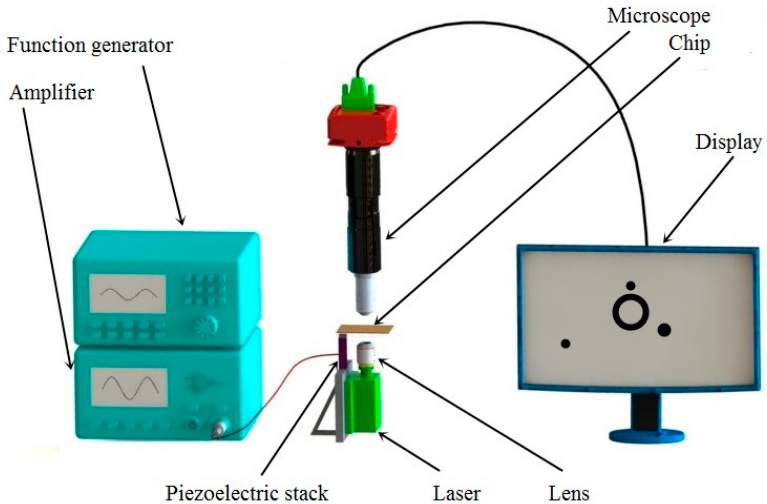
Figure 2. Schematic of the system setup.